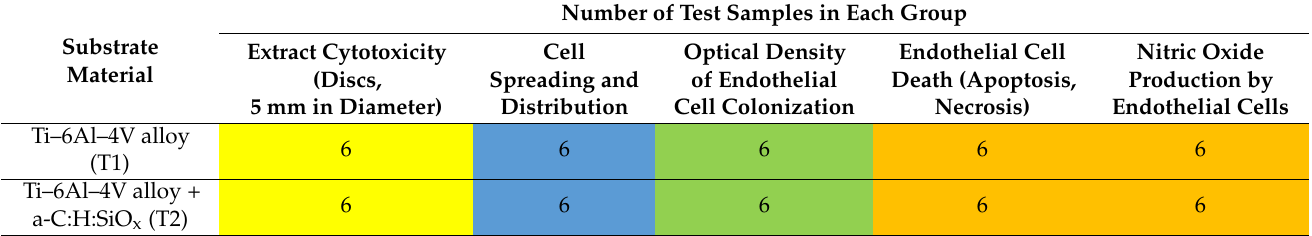
Table 2. Sample distribution for in vitro biomedical